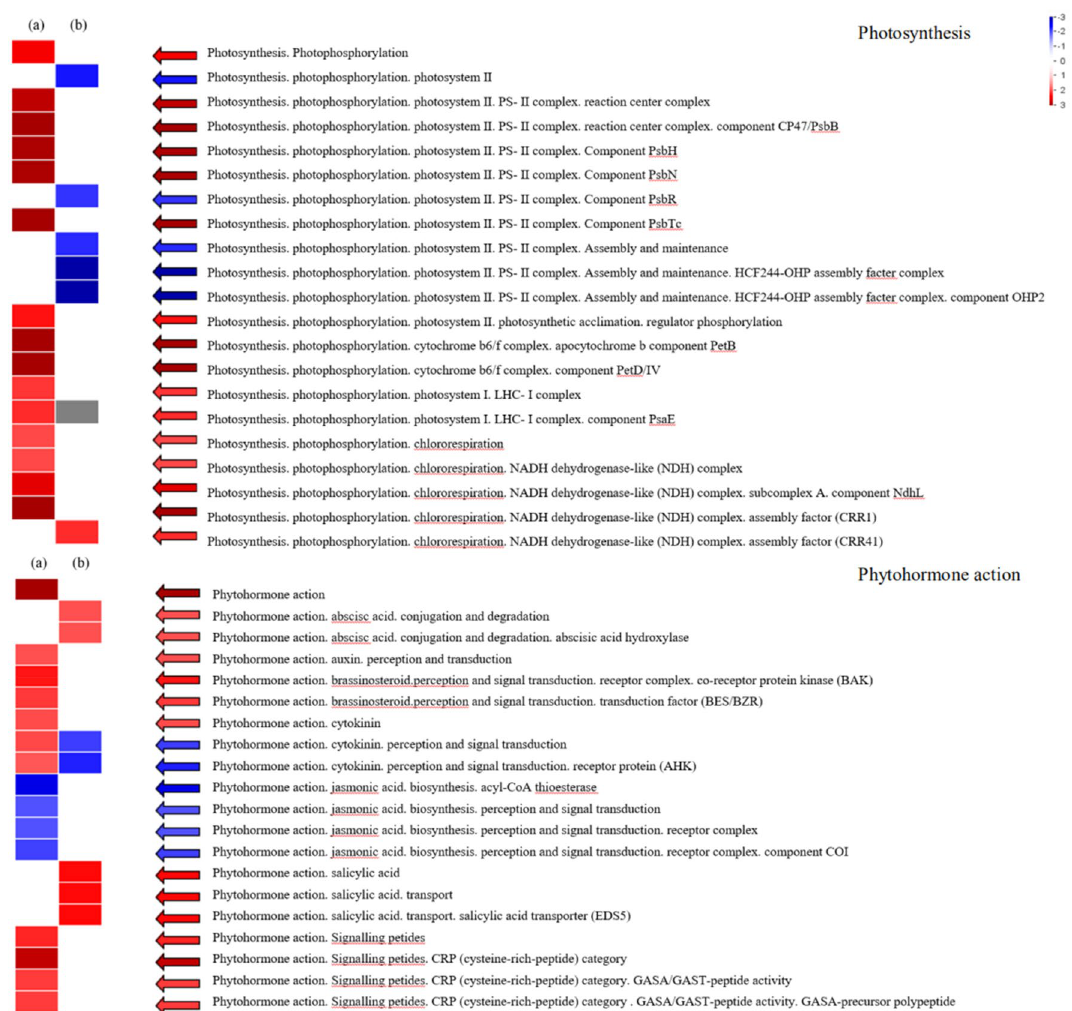
Figure 7. PageMan analysis of differential gene expressions in photosynthesis (above) and plant hormone action (below). ( a ) CK versus LT groups and ( b ) CK versus HT groups. The shades of the colours indicate the levels of differential expression, and each square represents a differentially expressed gene.